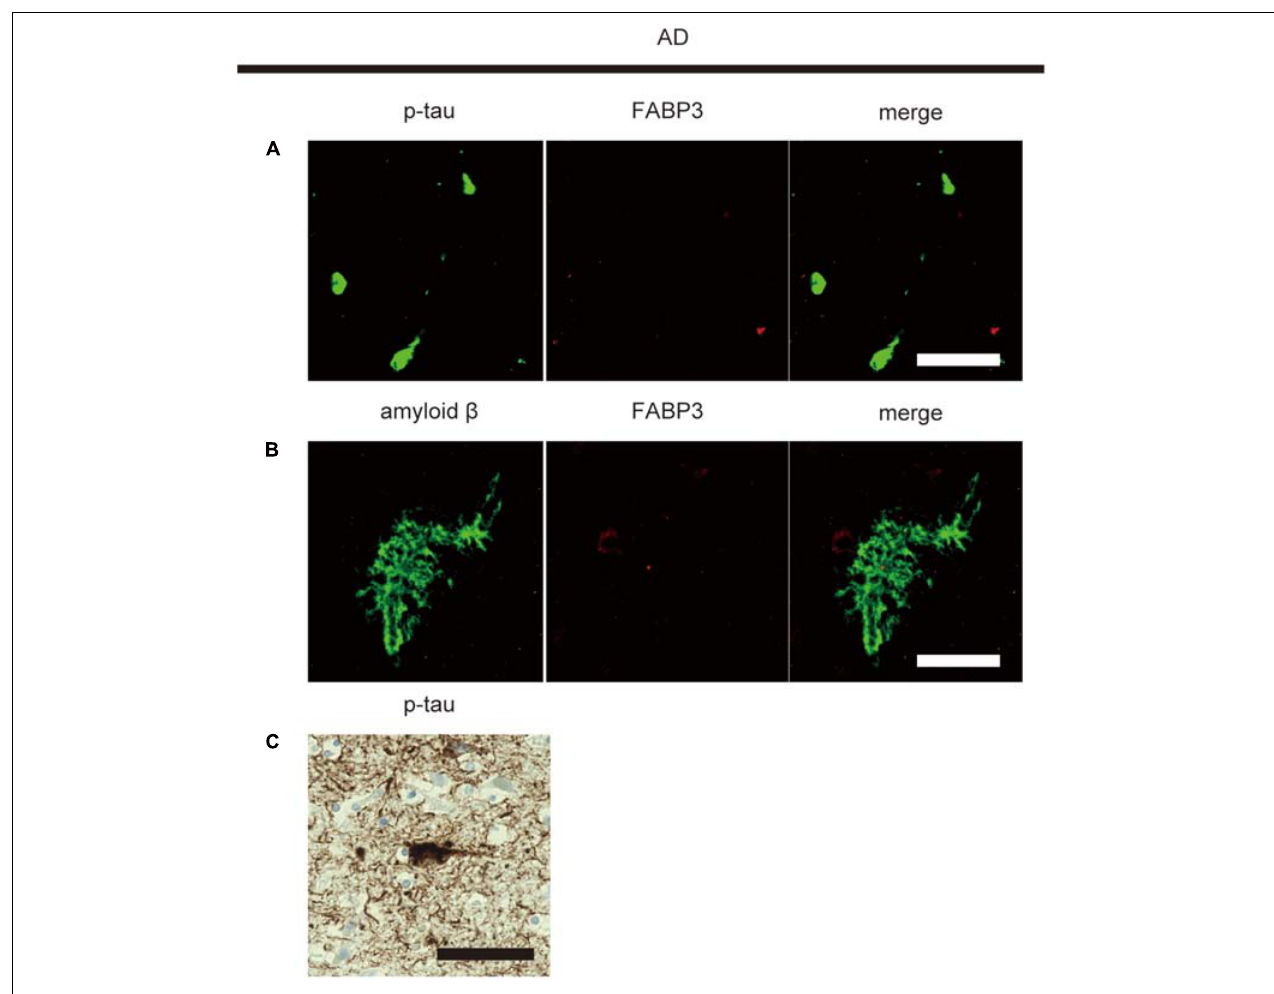
FIGURE 3 | No FABP3 protein expression in AD pathologyIF staining of FABP3 (red) and p-tau aggregates (green) in the frontal cortex in AD tissue (A) . IF staining of FABP3 (red) and amyloid β aggregates (green) in the frontal cortex in AD tissue (B) . FABP3 accumulation was not observed in amyloid β aggregates (A) or p-tau aggregates (B) in AD tissue. Nuclear staining with hematoxylin showed that p-tau-positive aggregates were NFTs (C) . Scale bars = 50 µ